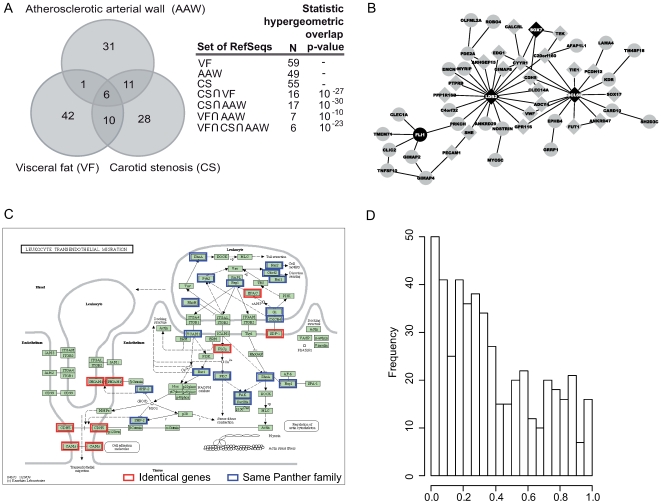
Intersection, network and bioinformatic analyses of the A-module.(A) Venn diagrams showing overlaps of genes in the A-module (three clusters related to extent of atherosclerosis) (Figure 2, Figure 3, Figure 4). Seven genes were found in both the atherosclerotic arterial wall and visceral fat clusters (P = 10−10), 17 in the atherosclerotic arterial wall and carotid stenosis clusters (P = 10−30), and 16 in the visceral and carotid stenosis clusters (P = 10−27). Six genes were found in all three clusters (P = 10−23). The union of all three clusters represented 128 genes. (B) A gene regulatory network inferred by co-expression of A-module genes using genome-wide expression data from the atherosclerotic arterial wall, carotid stenosis tissue, and visceral fat. Network edges are supported by at least two of the datasets, resulting in a total of 49 nodes. Marked in black are nodes (genes) with known regulatory activity, which are prioritized by the algorithm (Text S1). Marked as diamonds are 24 genes present in intersections between at least two of the clusters in Figure 5A (n = 27). (C) The TEML pathway. Marked in red are eight genes in the A-module that perfectly matched genes in the TEML pathway (P = 6.6×10−5). Marked in blue are 15 genes in the A-module that were associated with the TEML pathway according to Panther family annotation in DAVID. For a list of all genes in the TEML pathway and Panther families see Table S7 and Table S8, respectively. (D) The P-value distribution of 484 eSNPs (SNPs with allele distribution affecting gene expression) in the A-module indicating association with CAD according to a recent GWAS, the WCTTT study [10].